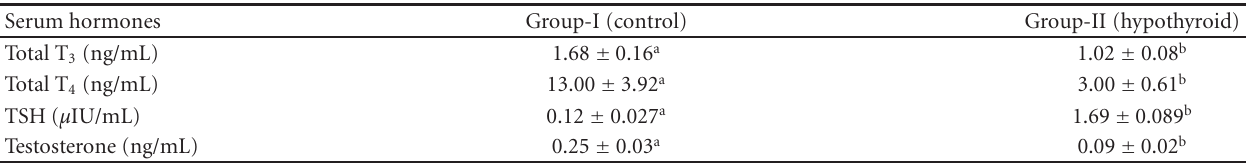
Table 3: E ff ect of neonatal PTU treatment on serum total T 3 , total T 4 , testosterone levels (ng/mL), and thyroid stimulating hormone (TSH) level in µ IU/mL). Data are expressed as mean ± S.D. of 5 observations and subjected to unpaired Student’s t -test. Statistical significance was accepted at P < 0 . 05. Control and hypothyroid groups were found to di ff er significantly at P < 0 . 05 as represented by superscripts of di ff erent letters. Group-I (control): 30-day-old control rats; Group-II (hypothyroid): 30-day-old rats with PTU treatment from day 1 postpartum to day 30 postpartum.